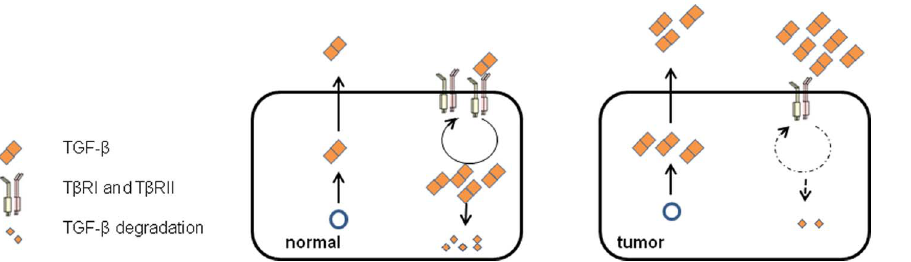
Figure 9. Model of how normal and cancer cells regulate the extracellular levels of TGF- b . The concentration of extracellular TGF- b is maintained by the balance between cellular production of TGF- b and depletion by the endocytosis. The underexpression of Dab2 and impaired TGF- b depletion in cancer cells lead to increased extracellular TGF- b concentration and cancer progression.